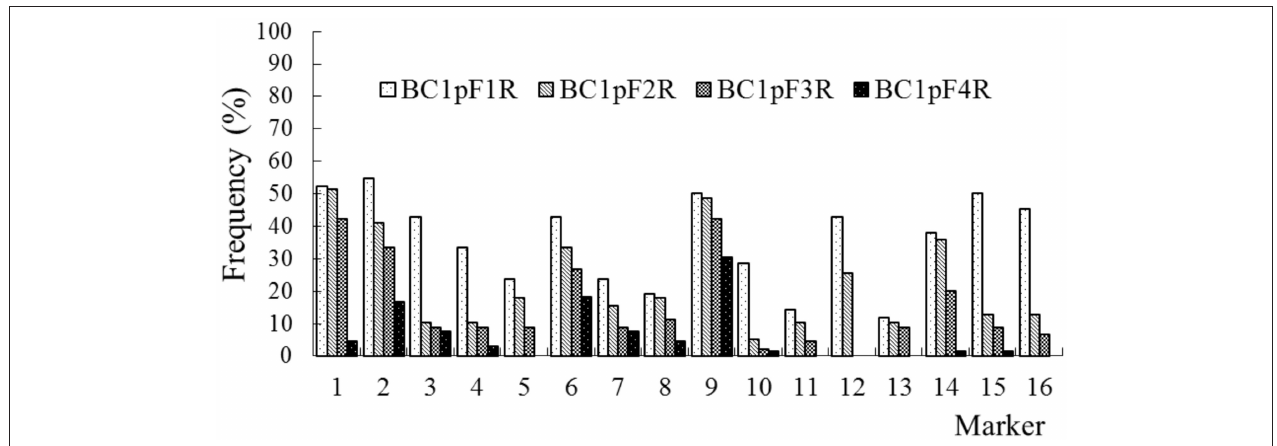
FIGURE 10 | Frequency of the marker specific to the C-chromosome of Brassica napus in the first (BC1pF1R)- to fourth (BC1pF4R)-generation progenies of BC1. BC1pF1R to BC1pF4R are the glyphosate-tolerant first- to fourth-generation progenies from the first backcross generation (BC1) of F1R × wild Brassica juncea . F1R indicates the glyphosate-tolerant F1 hybrids obtained from wild B. juncea × glyphosate-tolerant transgenic oilseed rape. Progenitors in front of the × are always the maternal plants, and progenitors after the × are always the paternal plants.